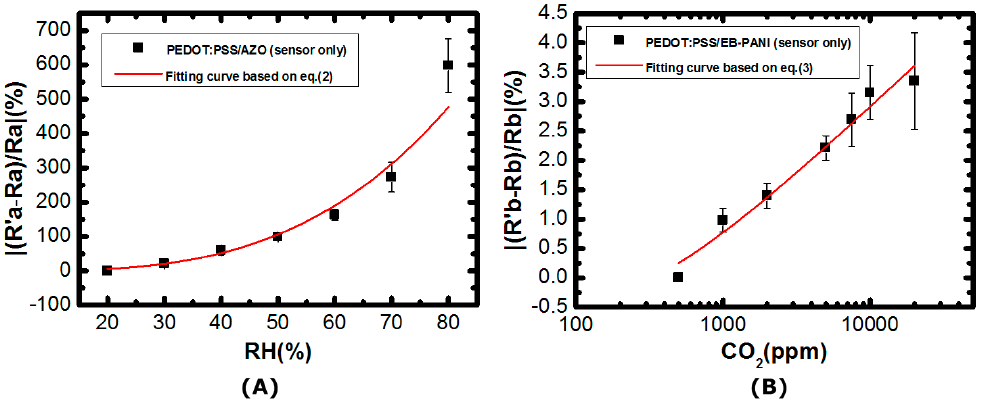
Figure 4. ( A ) The measured characteristics of the designed humidity sensor; ( B ) The measured characteristics of the designed CO 2